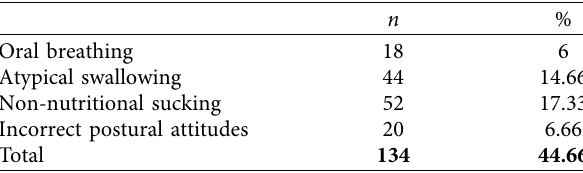
Table 5: Prevalence and distribution of oral